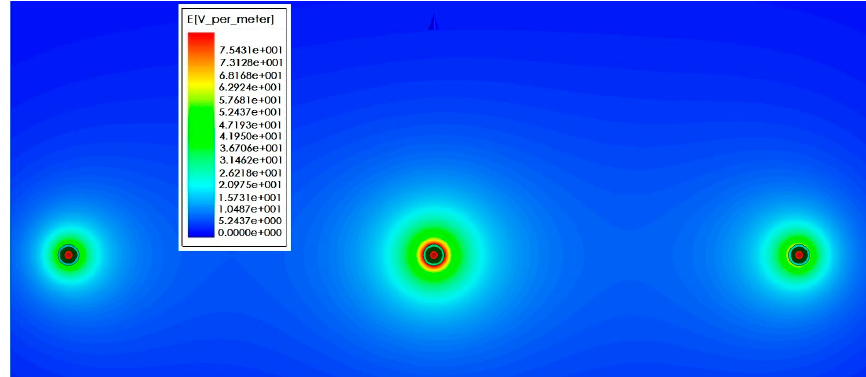
Figure 16. Electric field distribution after introducing sensor.